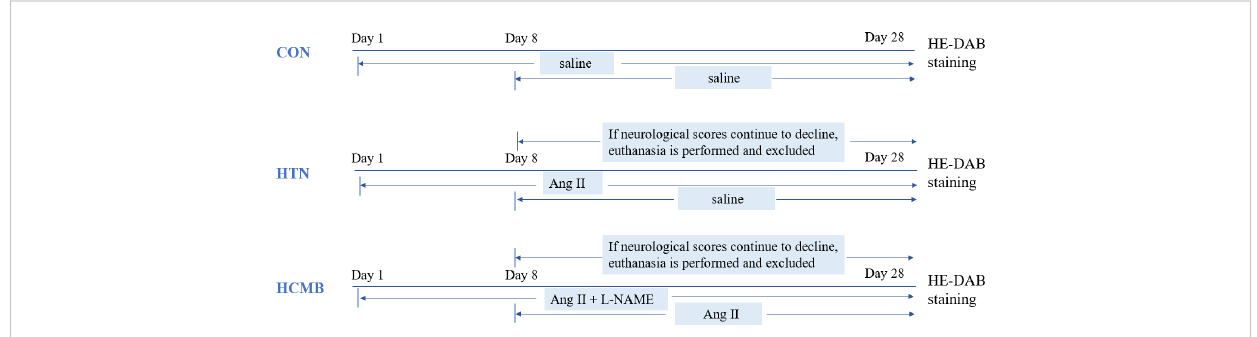
FIGURE 2 Diagram of experimental modeling process. CON, control group; HTN, hypertension; HCMB, hypertensive cerebral microbleeds; Ang II, angiotensin II; L-NAME, levonitroarginine methyl ester; HE-DAB, Hematoxylin eosin staining and diaminobenzidine staining.